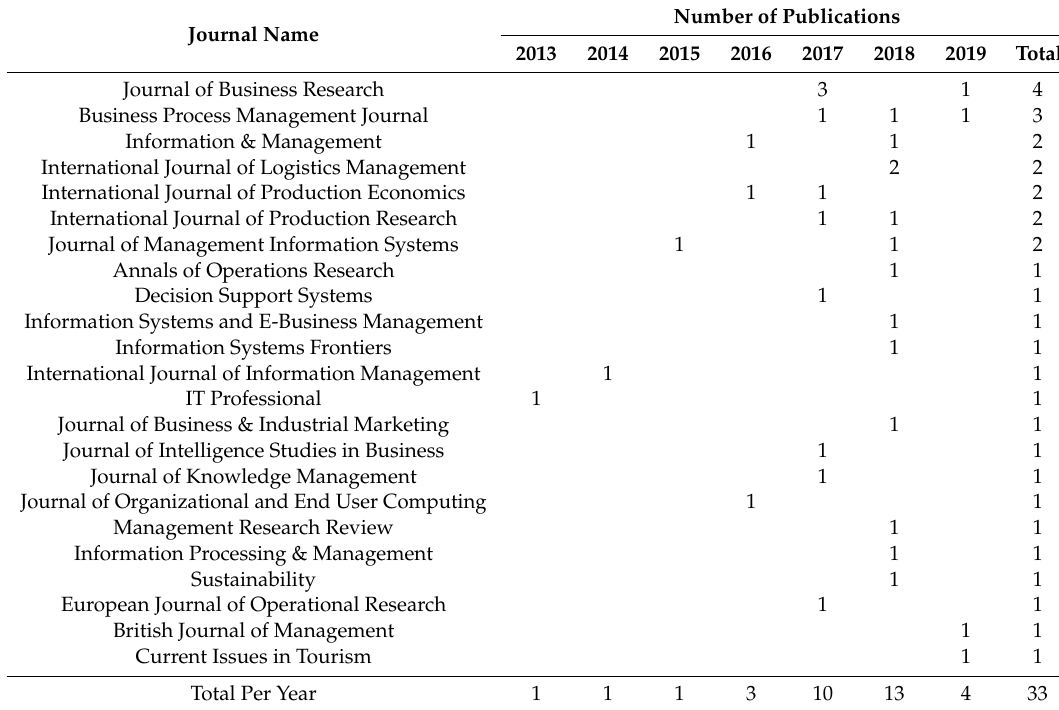
Table 1. The number of publications in each journal by